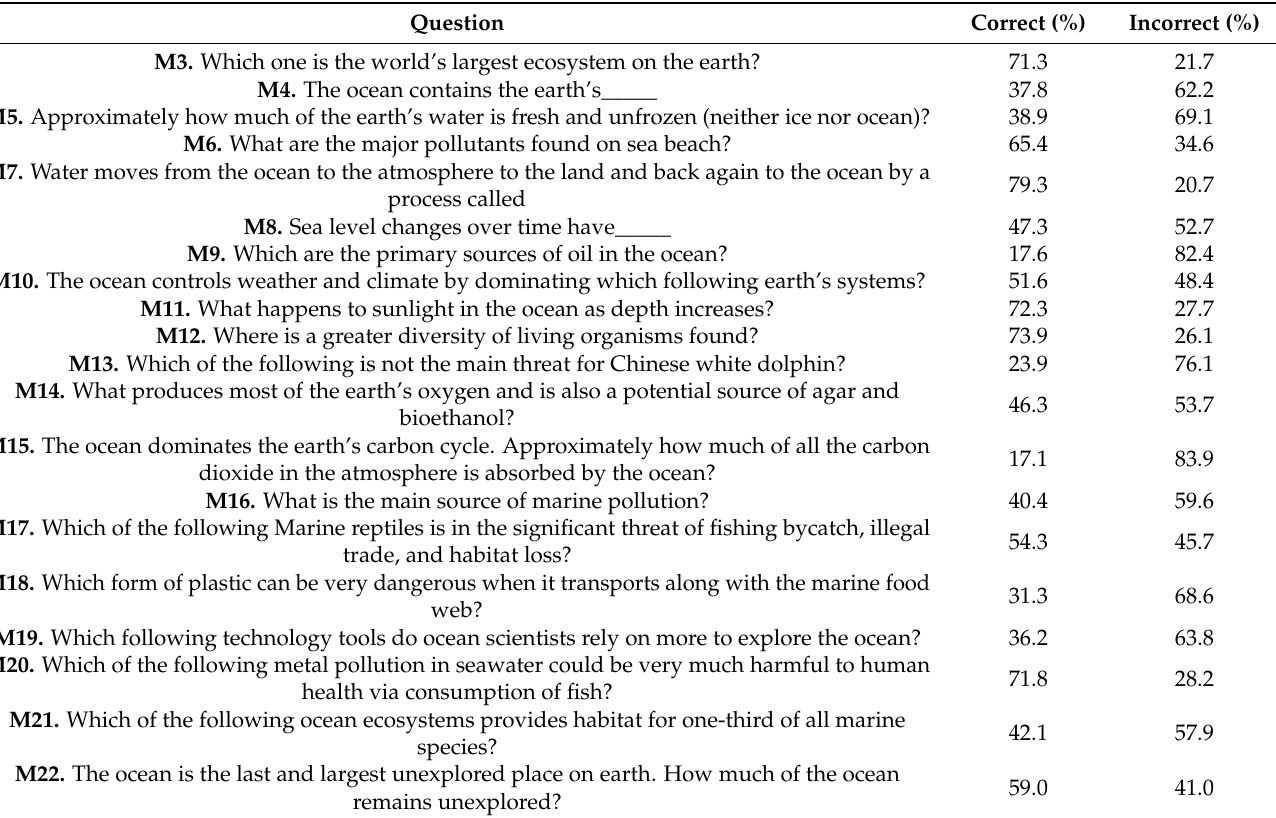
Table 4. Students’ responses to general marine environmental knowledge questions.